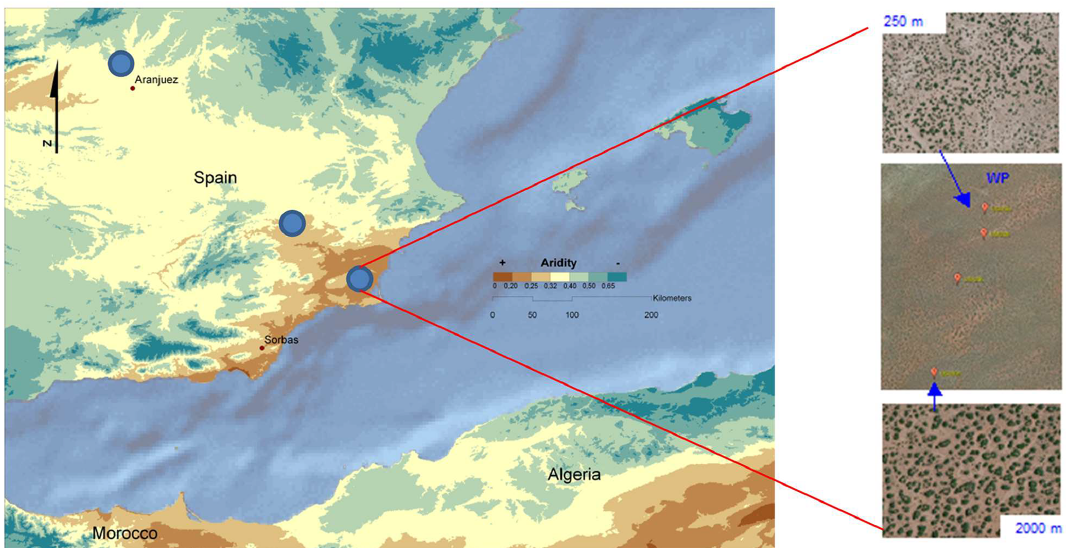
Figure 3. Hypothetical example of the survey scheme, showing the location of three survey sites (blue dots in the left panel) and the location of plots along watering points (WPs) within one of these sites. In the right panels, the image in the center shows the location of three plots, and the upper and lower images show the plots located at 250 and 2000m from the watering point,